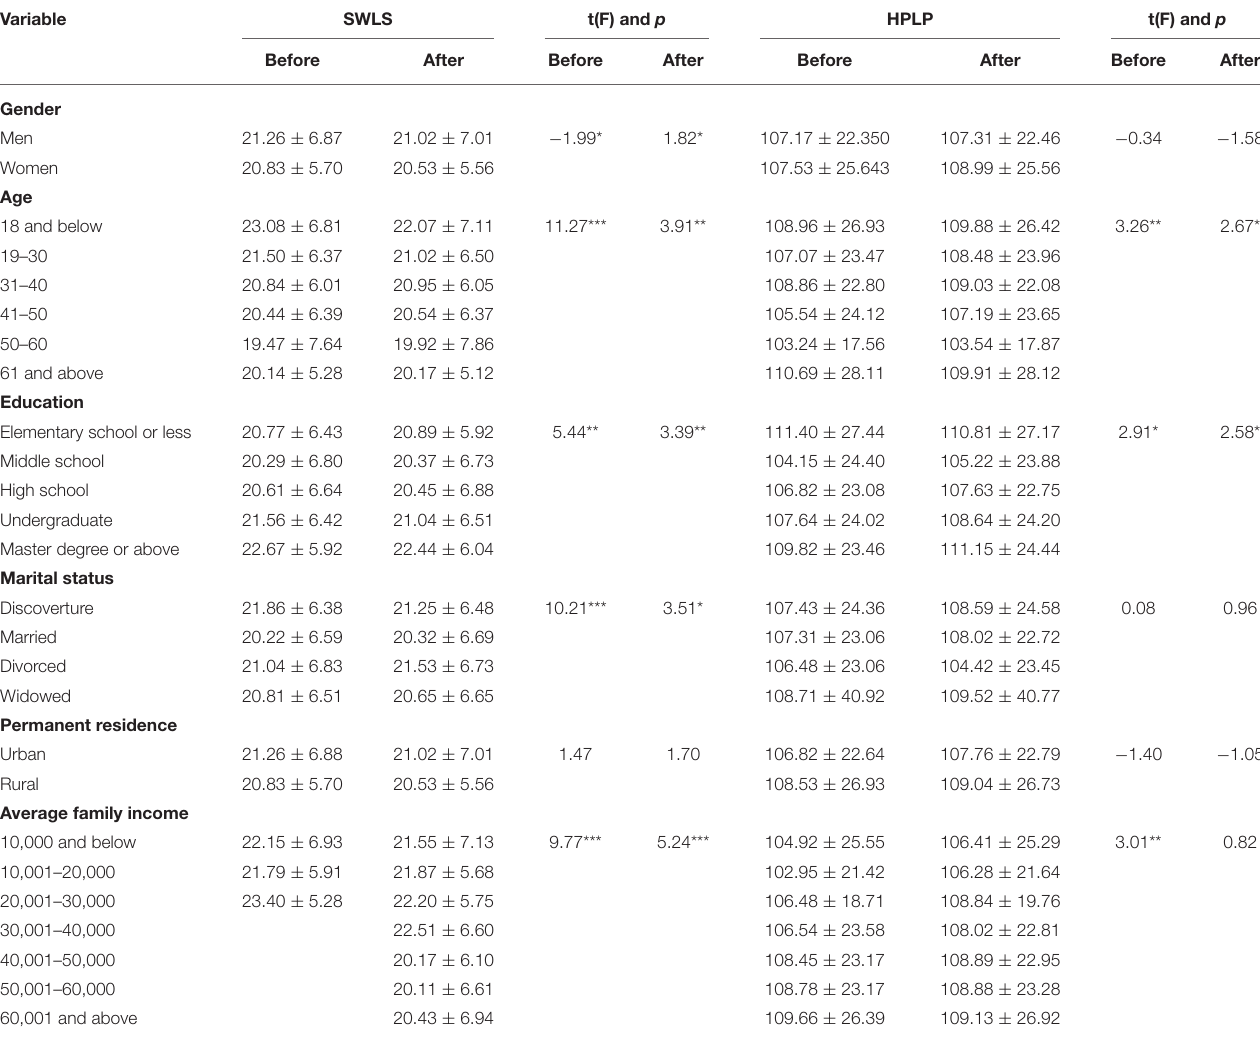
TABLE 3 | Comparison of HPLP and SWLS with general characteristics before and after the COVID-19 pandemic ( N = 2,054). Variable SWLS t(F) and p HPLP t(F) and p Before After Before After Before After Before